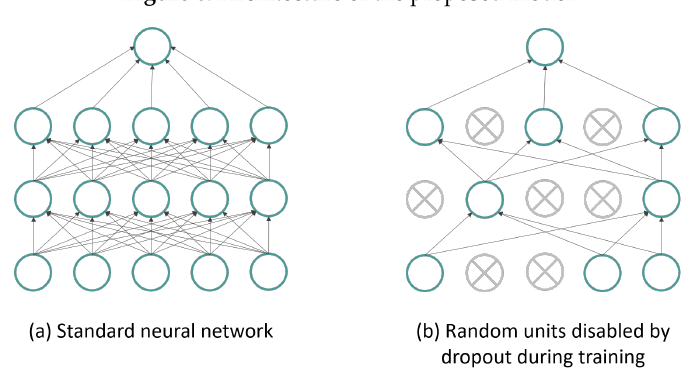
Figure 6. Architecture of the proposed model.